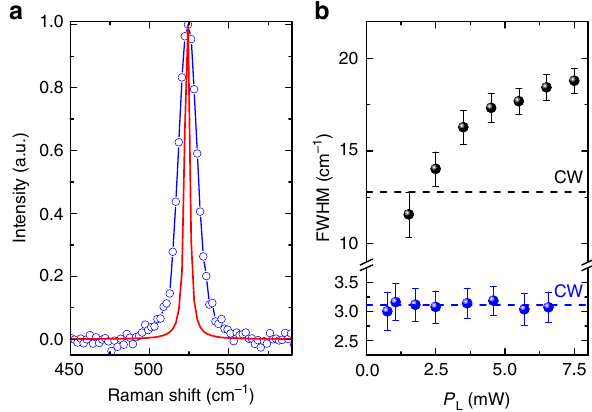
Fig. 6 Raman response of Si for pulsed laser excitation. a Raman spectrum of Si measured for ultrafast laser excitation and 6.6 mW average power. (blue line) Lorentzian fi t. (red line) laser bandwidth deconvoluted spectrum. b FWHM(Si) as a function of P L (blue symbols) does not show any deviation from the CW FWHM(Si) (dashed blue line). FWHM(G) under the same excitation conditions (black symbols) deviates from the CW regime (dashed black line). Error bars represent the 95% con fi dence level of the best fi t of the Si ( a ) and SLG (G band)